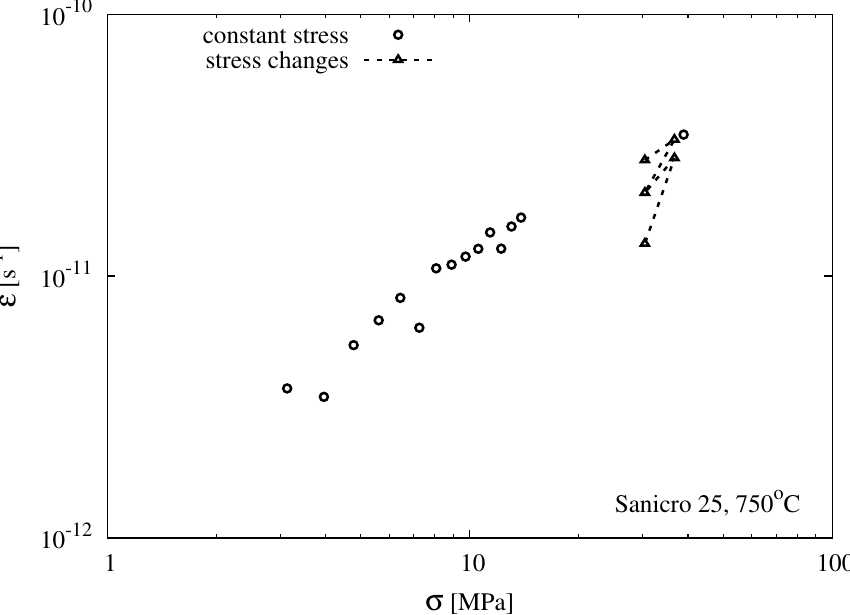
Figure 4. The creep rates ˙ ε for 750 ◦ C, measured at the end of each creep curve segment. The creep rates from constant stress tests [9] are plotted for